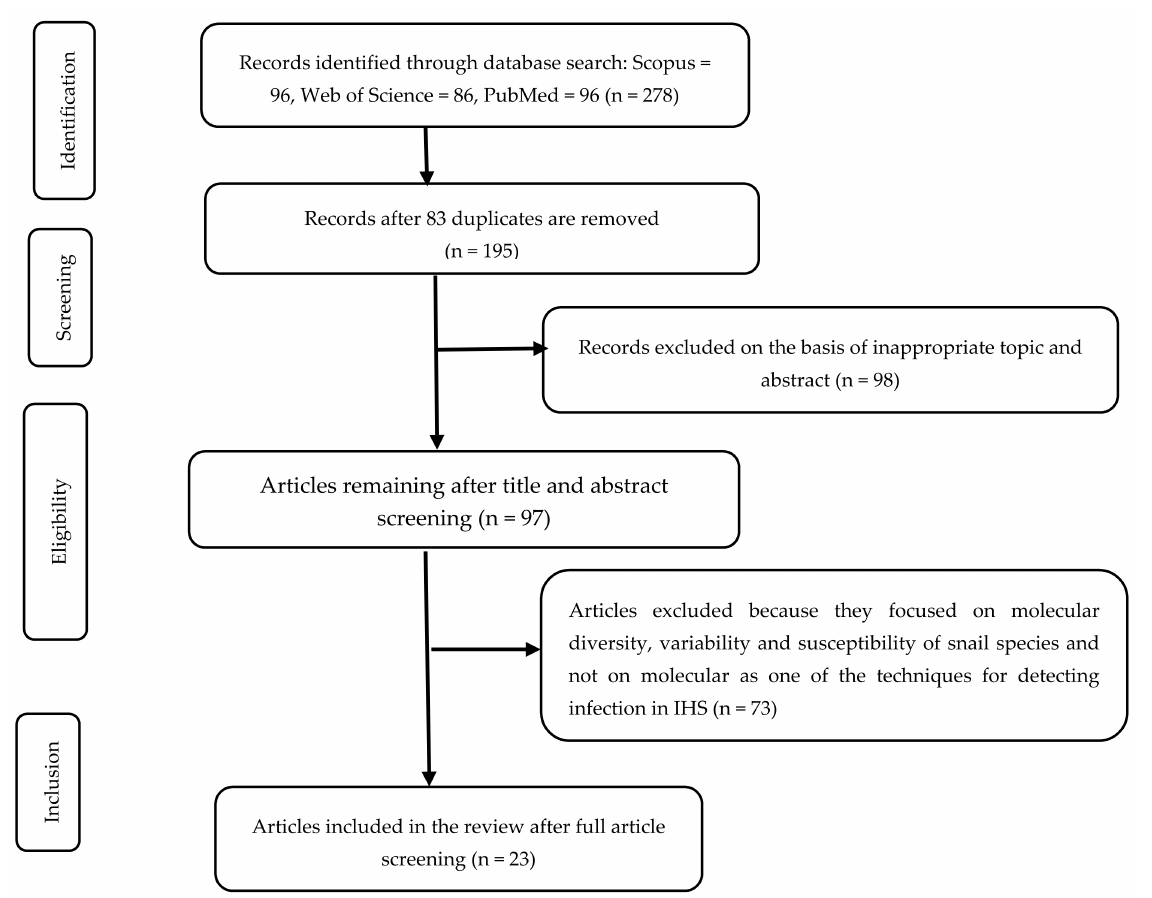
Figure 1. Preferred Reporting Items for Systematic Reviews and Meta-Analyses (PRISMA) flow diagram showing the process of article